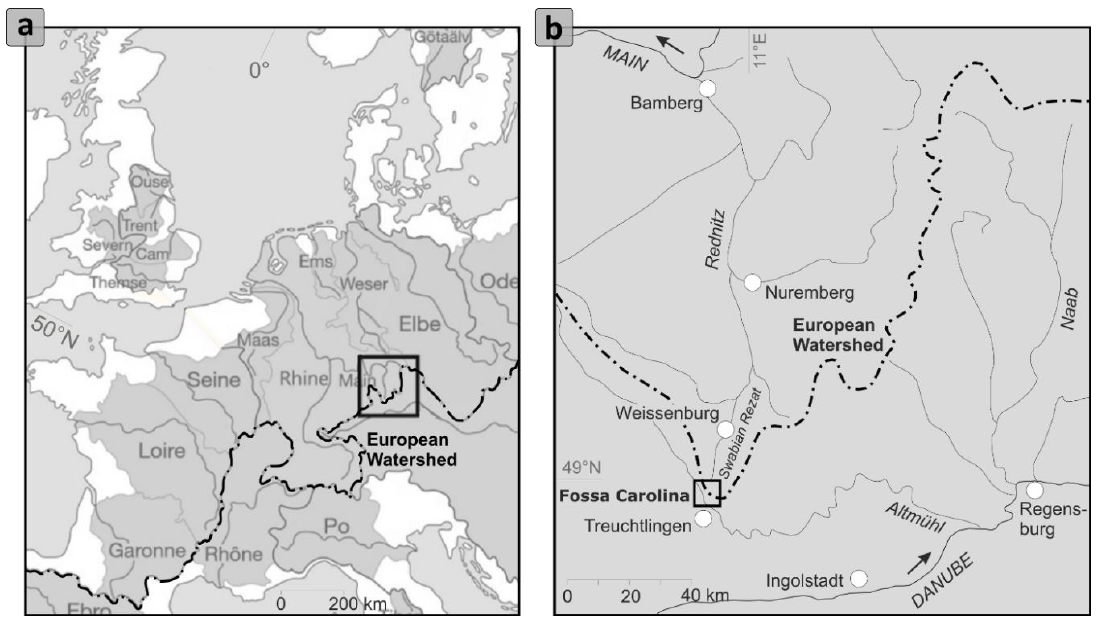
Figure 1: Geographical setting of the study area. a ) Main Central European drainage basins and the Central European Watershed. b ) Regional setting of the Fossa Carolina in relation to tributaries of the Rhine-Main drainage system and the Danube drainage system (modified after Zielhofer et al. [32]). The canal course can be divided into five sections in relation to surface structures and trench bottom depths (see Figure